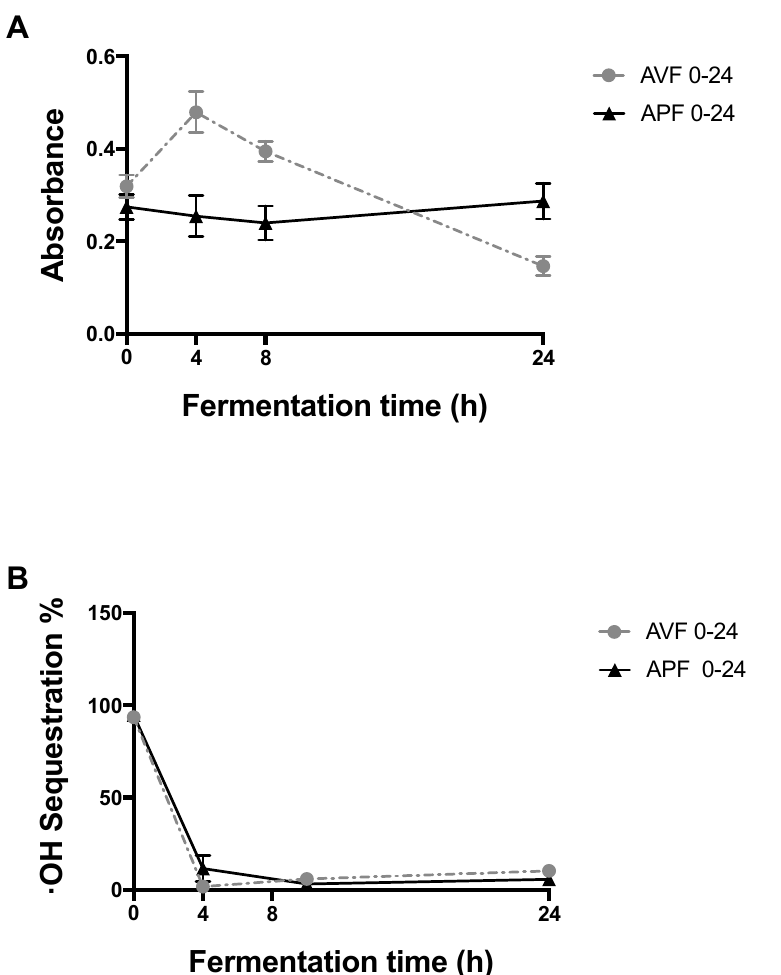
Figure 4. Changes in antioxidant activity during colonic fermentation of Aloe vera gel (AV) and its polysaccharide extract (AP). ( A ) Changes in reducing power (Abs 700 nm), due to colonic fermentation. ( B ) Changes in % of sequestration of hydroxyl radical · OH due to colonic fermentation. ( B ) The results are expressed as the ME ± DS, n = 3.